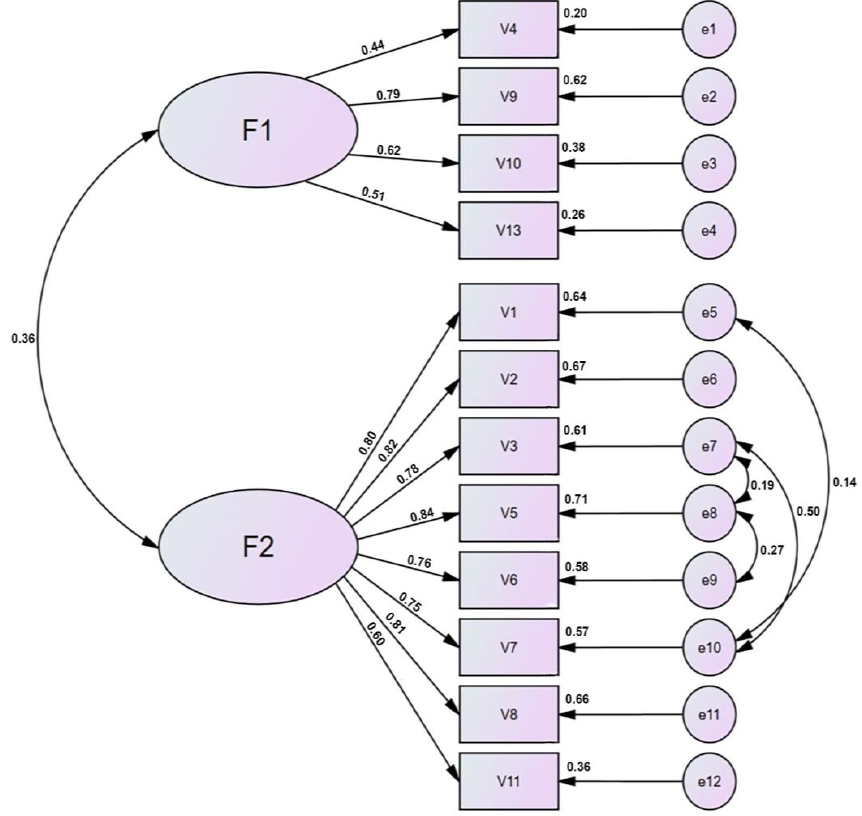
Figure 2. OPQOL-Brief factor